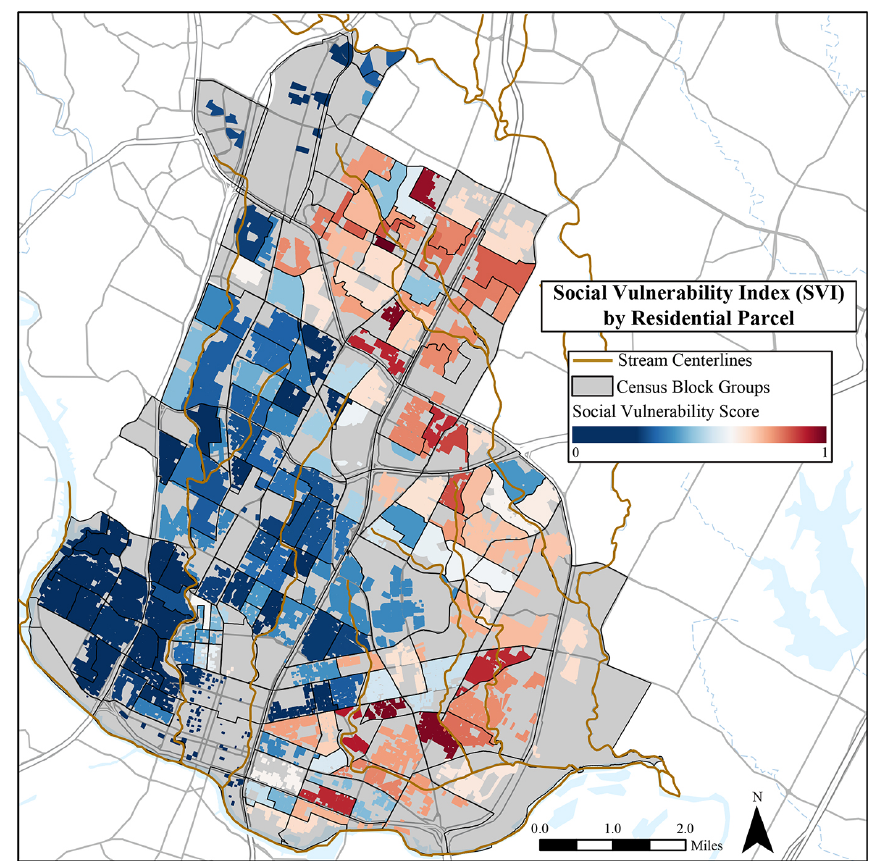
Figure 8. Austin, Texas, relative social vulnerability index (SVI), with 1 being most vulnerable and 0 being least